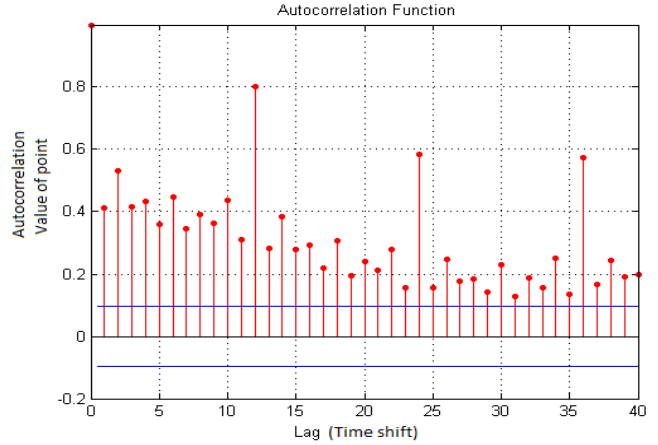
Figure 6. Detection of repetitive hand gesture segment using autocorrelation